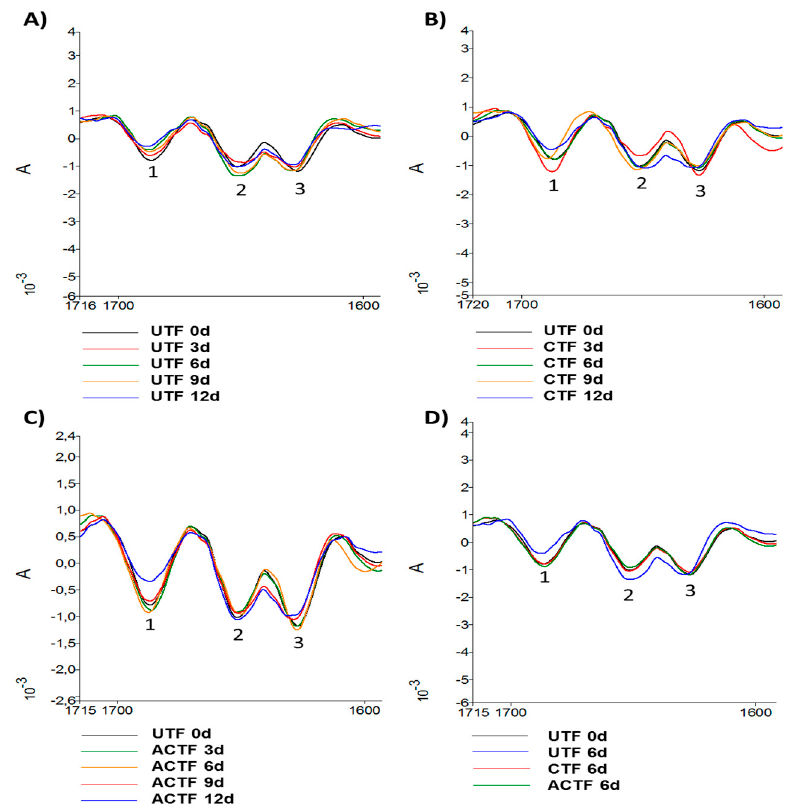
Figure 11. ATR-FTIR second derivative of the absorption spectra in the region 1700–1600 cm − 1 , of uncoated (UTF) ( A ), coated (CTF) ( B ), and coated with ELO (ACTF) ( C ) trout fillets, after 12 days of storage at 4 ◦ C. The comparison of the spectrum of trout fillet at 0d and after 6 days of storage is shown in ( D ). 1 = 1628 cm − 1 peak; 2 = 1652 cm − 1 peak; 3 = 1687 cm − 1 peak. Spectra are representative of three samples. d =